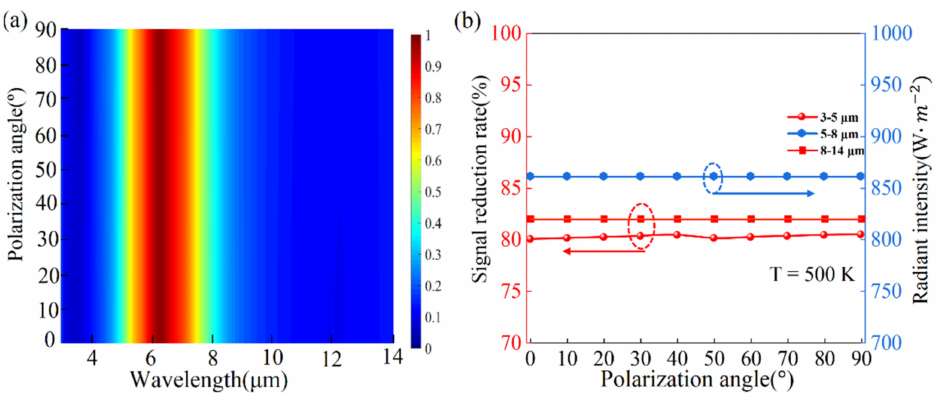
Figure 6. ( a ) Spectral emissivity of cGST thermal emitter for different polarization angles, which change from 0 ◦ to 90 ◦ ; ( b ) is IR signal reduction rates of our designed cGST thermal emitter in wavelength ranges 3–5 µ m and 8–14 µ m at 500 K for various polarization angles, respectively. The radiant intensity (W/m 2 ) in the wavelength 5–8 µ m for various polarization